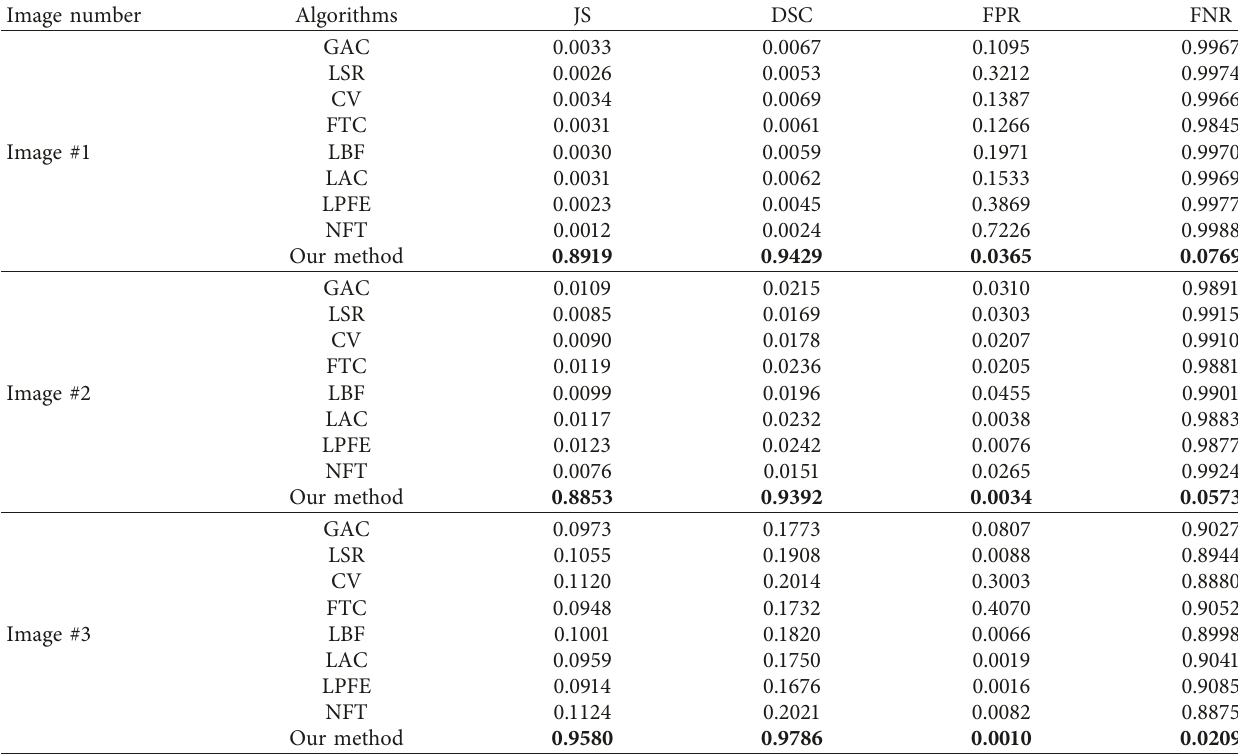
Table 3: Region overlap metrics of different algorithms corresponding to Figure 6 in the same